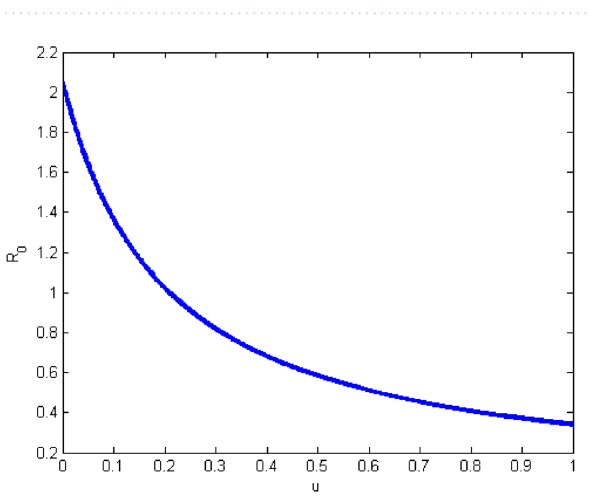
Figure 9. Variation of R 0 according to the vaccine effect.